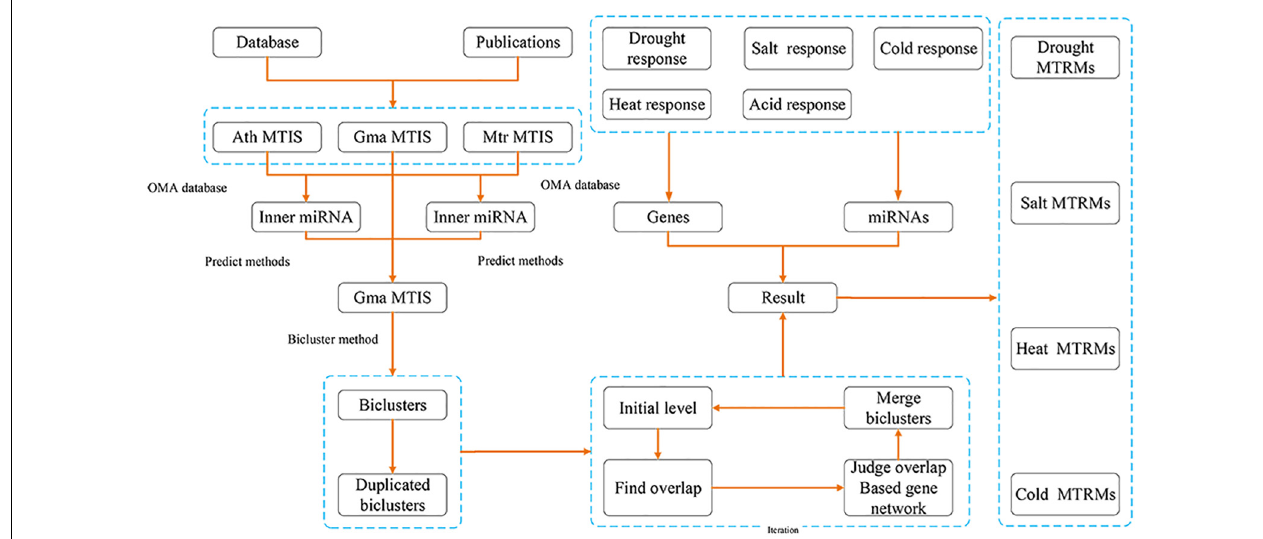
FIGURE 1 | Flowchart of the authors’ research method.